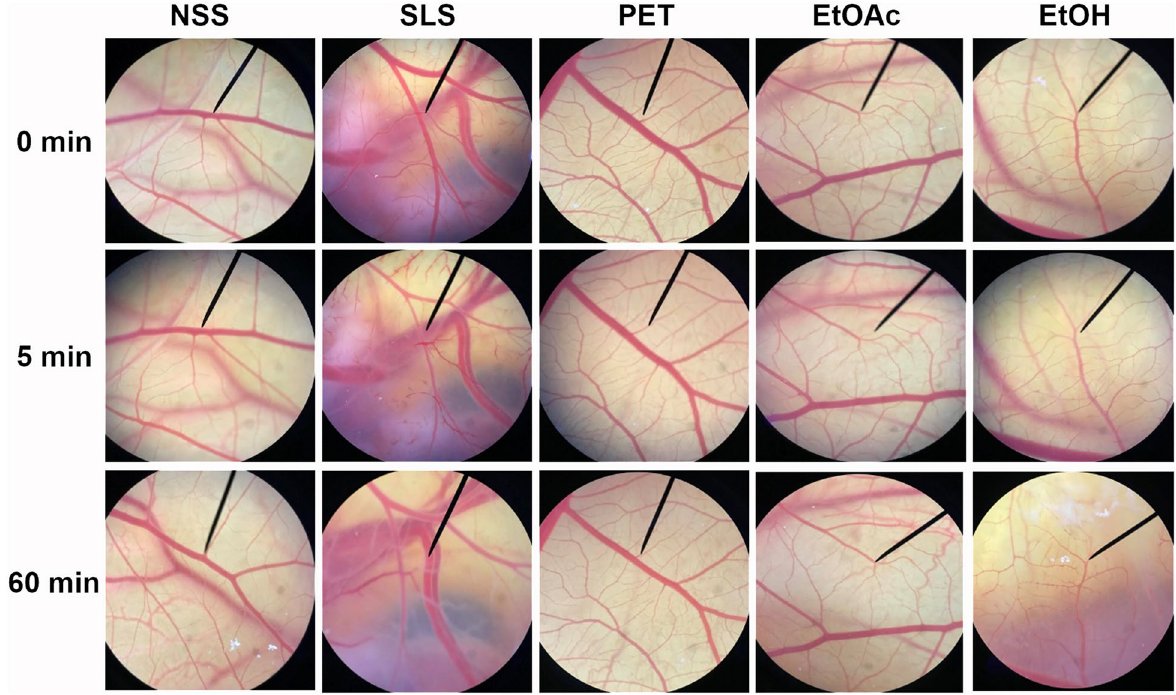
Figure 3. Chorioallantoic membrane of hen’s egg after exposure to normal saline solution (NSS), 1% w/v sodium lauryl sulfate (SLS), black D. longan seed petroleum ether extract (PET extract), black D. longan seed ethyl acetate extract (EtOAc extract), and black D. longan seed ethanolic extract (EtOH